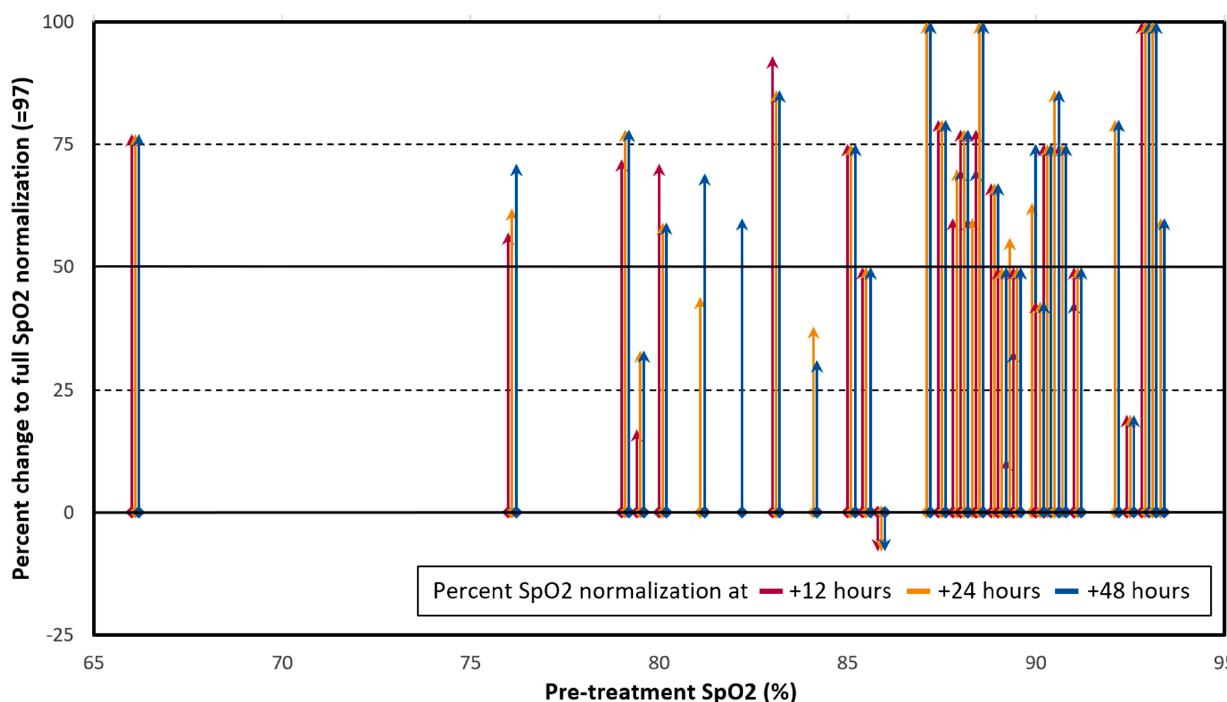
Figure 1. Changes in pre- to post-treatment SpO2 values, all on room air, for 34 severe COVID-19 patients treated with Ivermectin (IVM), doxycycline, and zinc, as percentages of optimal normalization to SpO2 = 97. Red, orange, and blue lines represent, respectively, changes in SpO2 values at +12, +24, and +48 h after the first dose of IVM. Arrows were shifted to the right slightly (<1.5 × axis units), as needed for clarity. For pre- and post-treatment SpO2 values S 0 and S 1 , the y axis is the percent of optimal normalization to SpO2 = 97, that is: 100 × (S 1 − S 0 )/(97 − S 0 ), capped at 100%. Mean (±SD) SpO2 changes (y values) were 55.1% ± 28.0% at +12 h, 62.3% ± 26.3% at +24 h, and 64.3% ± 24.5% at +48 h.